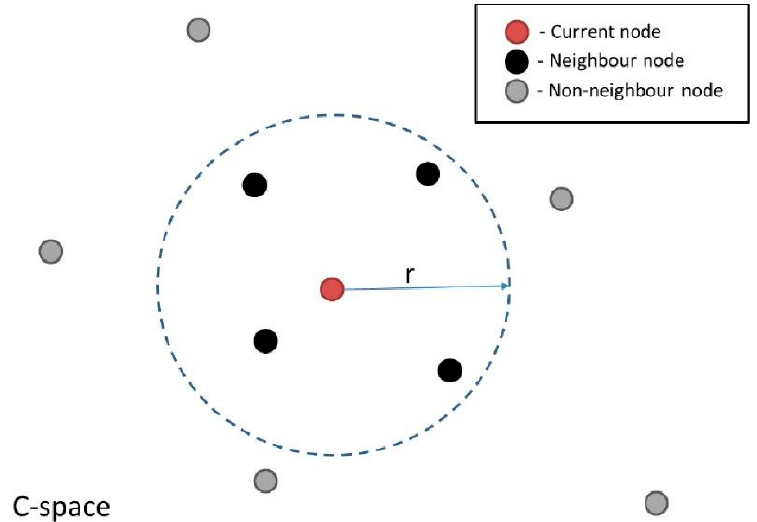
Figure 7. Illustration of nodes that are considered neighbors of a node being considered, with current node (red color), nodes lying within a specified radius r (black color) and all other nodes in the C-space (gray color).